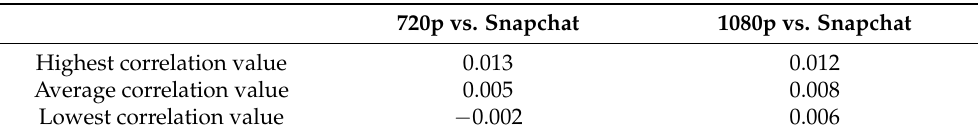
Table 3. Overview of the highest, average and lowest correlation values for both resolutions com- pared to Snapchat. 720p vs. Snapchat 1080p vs. Snapchat Highest correlation value 0.013 0.012 Average correlation value 0.005 0.008 − 0.002 0.006